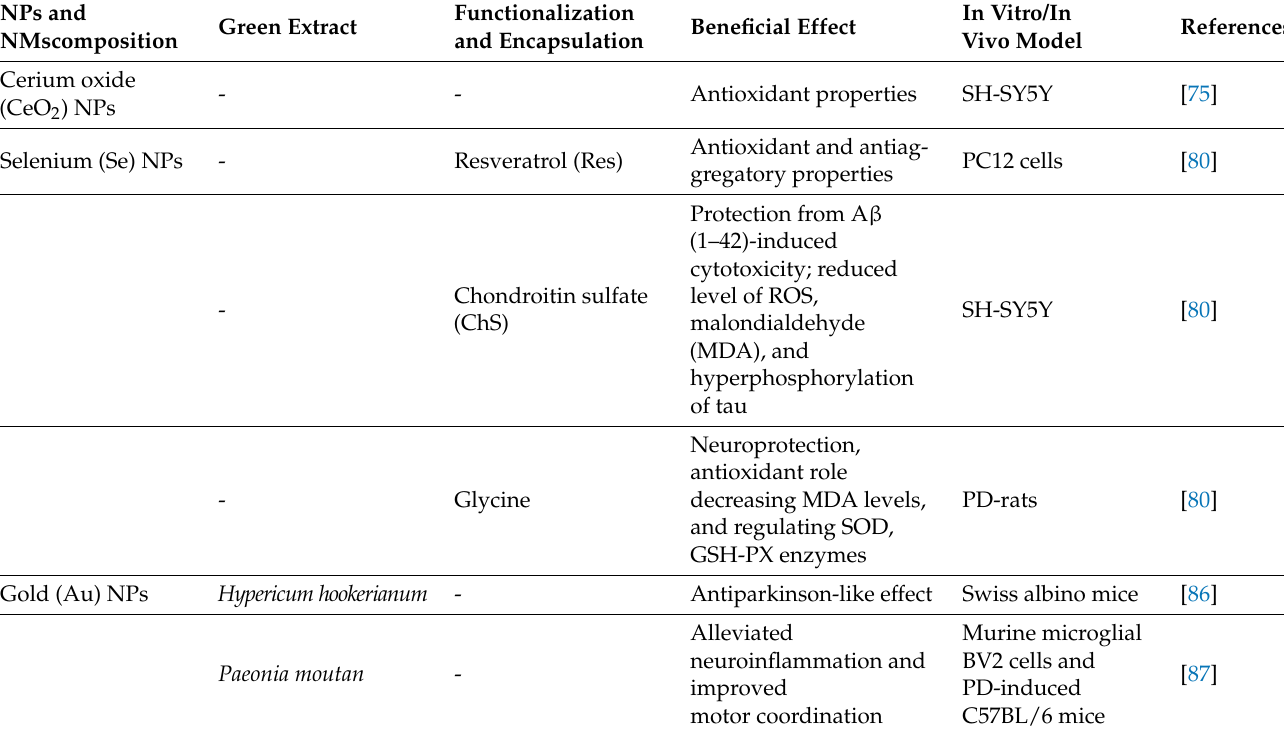
Table 1. Beneficial effects of different kinds of NPs in in vitro and in vivo